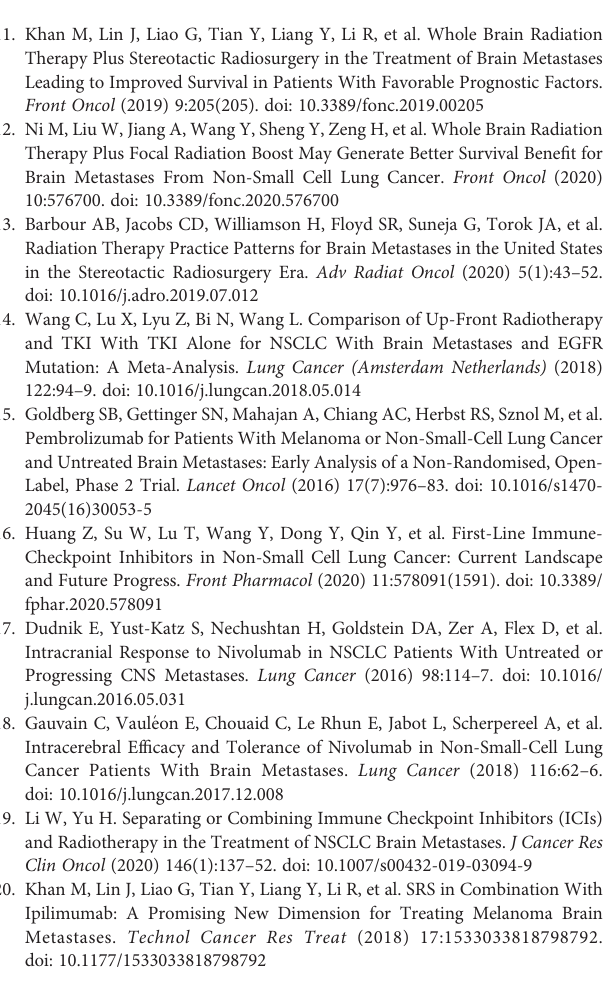
Supplementary Figure 1 | Kaplan-Meier overall survival (OS) curve for treatments in EGFR mutant NSCLC subgroup; WBRT alone (No PD-1), and WBRT plus PD-1 inhibition therapy (WBRT+PD-1). Cum, cumulative. Supplementary Figure2 | Kaplan-Meier progression-free survival (PFS) curvefor treatments in EGFR mutant NSCLC subgroup; WBRT alone (No PD-1), and WBRT plus PD-1 inhibition therapy (WBRT+PD-1). Cum,